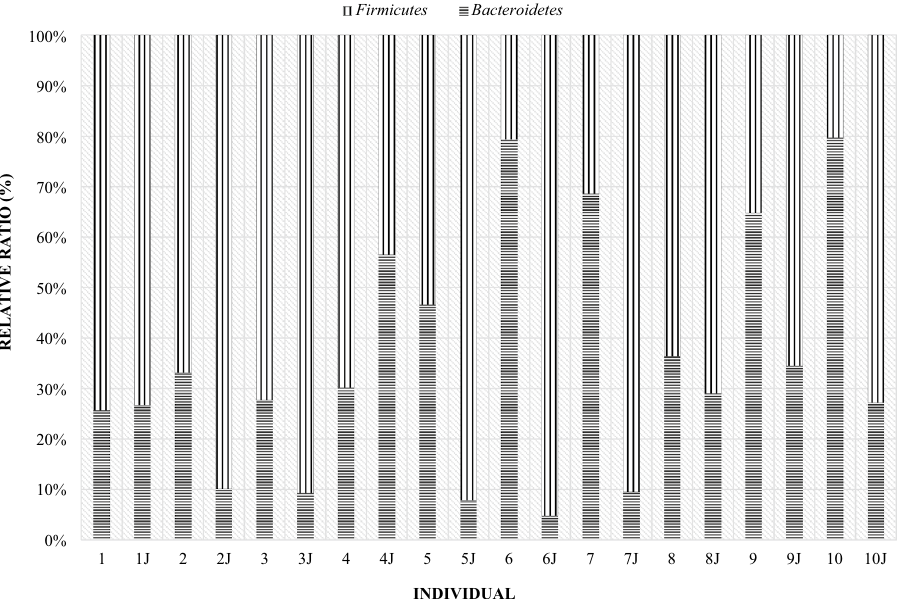
Figure 19. Comparison of Firmicutes and Bacteroidetes phylum at 28th day in mother and their twins digestive tract (1—mother, 1 J—twins).